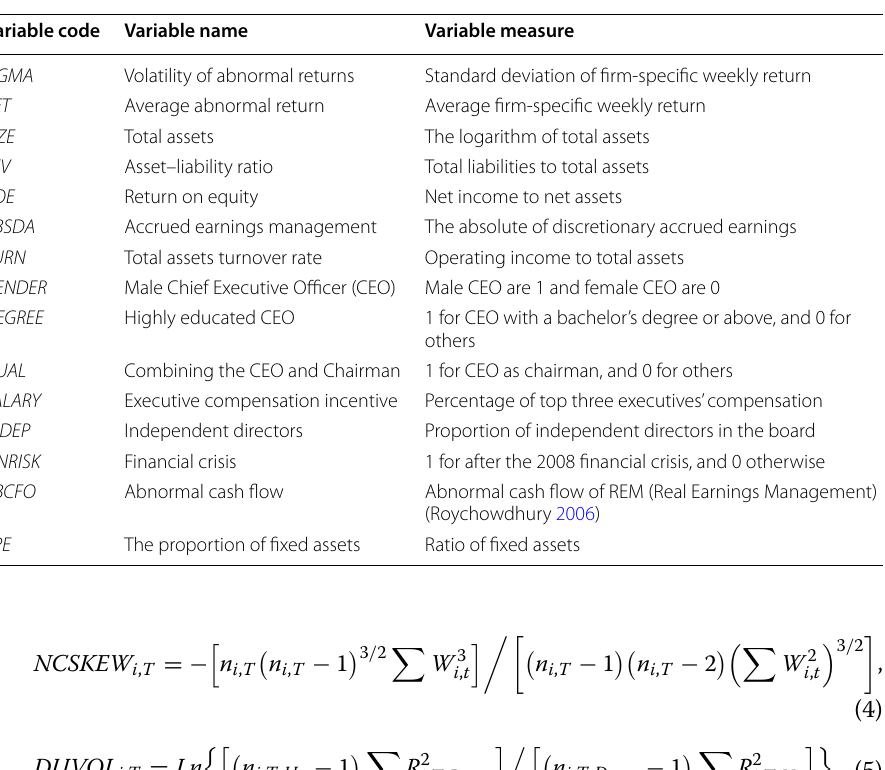
Table 3 Measures of other